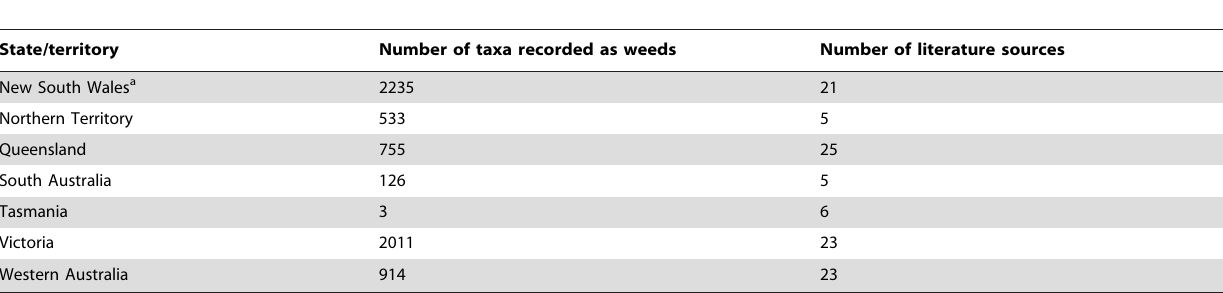
Table 1. Number of taxa in the dataset that are recorded as weeds in each Australian state and territory and number of literature sources available and consulted at the time the original database was built